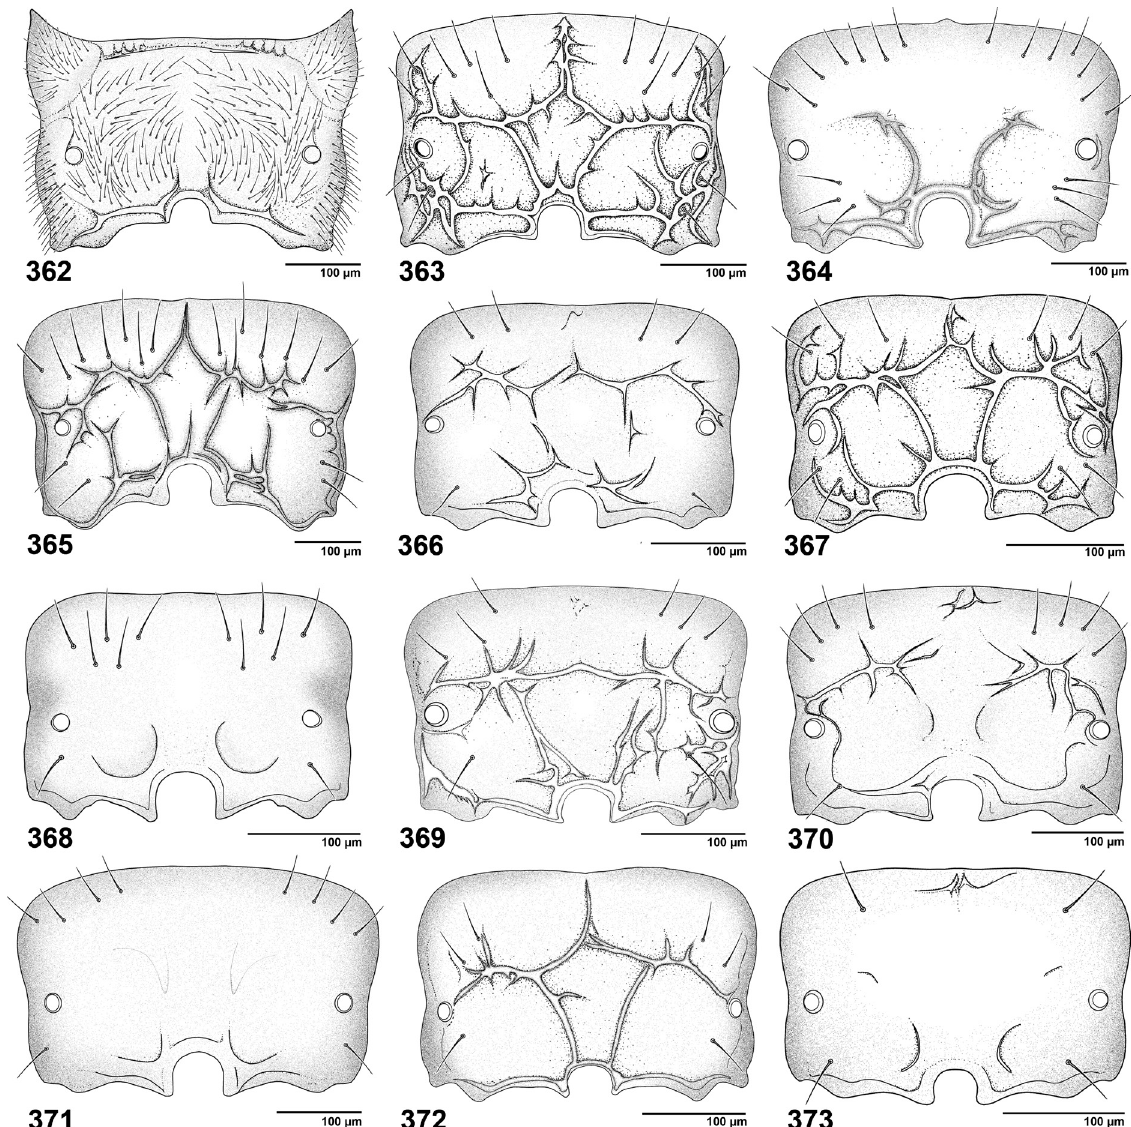
Figs 362–373. Dorsal aspect of propodeum (♀): 362 . Praon yomenae . 363 . Toxares deltiger . 364 . Trioxys asiaticus . 365 . Trioxys cirsii . 366 . Trioxys complanatus . 367 . Trioxys curvicaudus . 368 . Trioxys metacarpalis . 369 . Trioxys moshei . 370 . Trioxys pallidus . 371 . Trioxys pannonicus . 372 . Trioxys quercicola . 373 . Trioxys tanaceticola